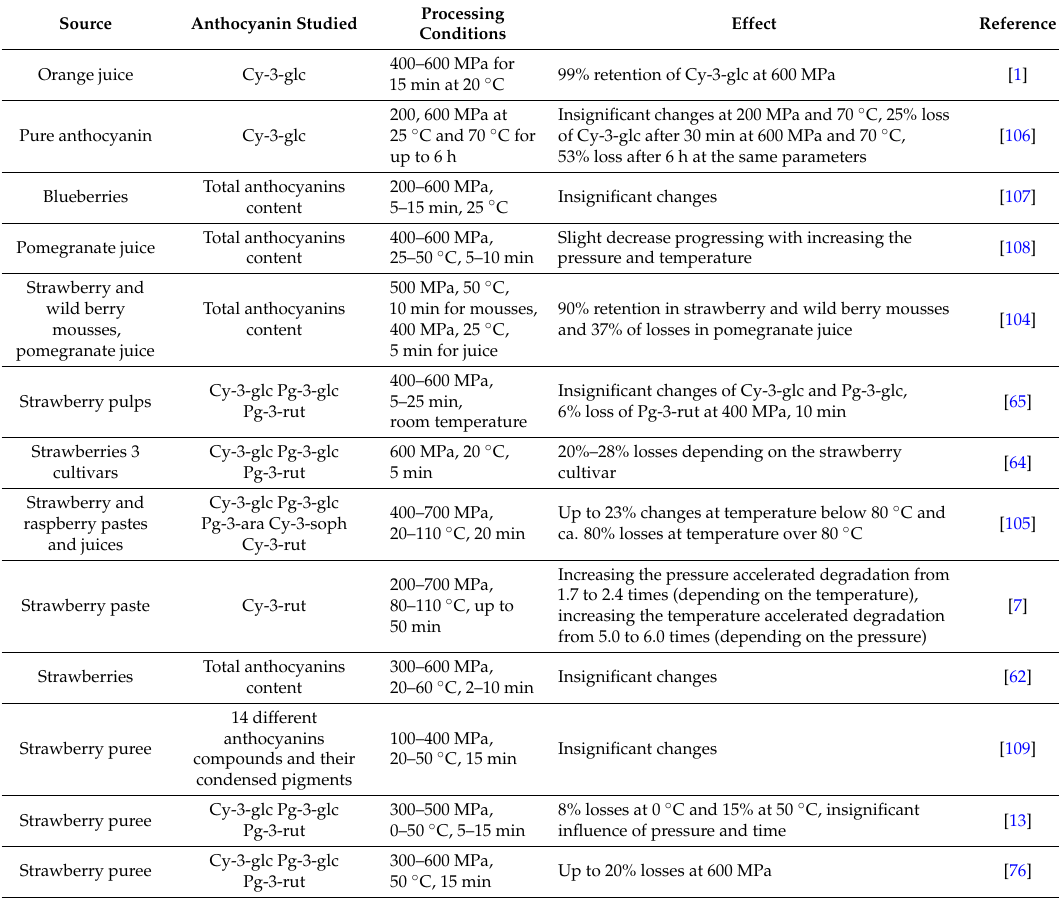
Table 2. Effect of HPP on the anthocyanins